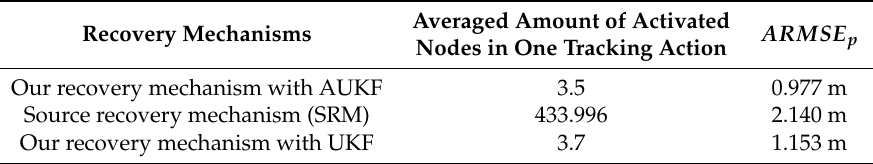
Table 4. Features of different recovery